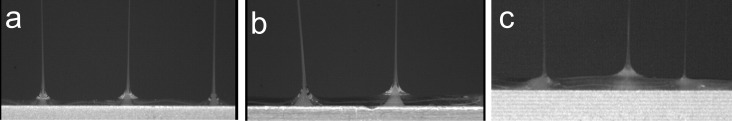
Video capture images core/sheath cone-jets using System A emitted from differing sheath slit widths.(a, b) Distinct core/sheath cone-jets were formed at slit widths of 1.5 and 2.2 mm, respectively. (c) Non-distinct core/sheath cone-jets were formed at a slit width of 3.0 mm.